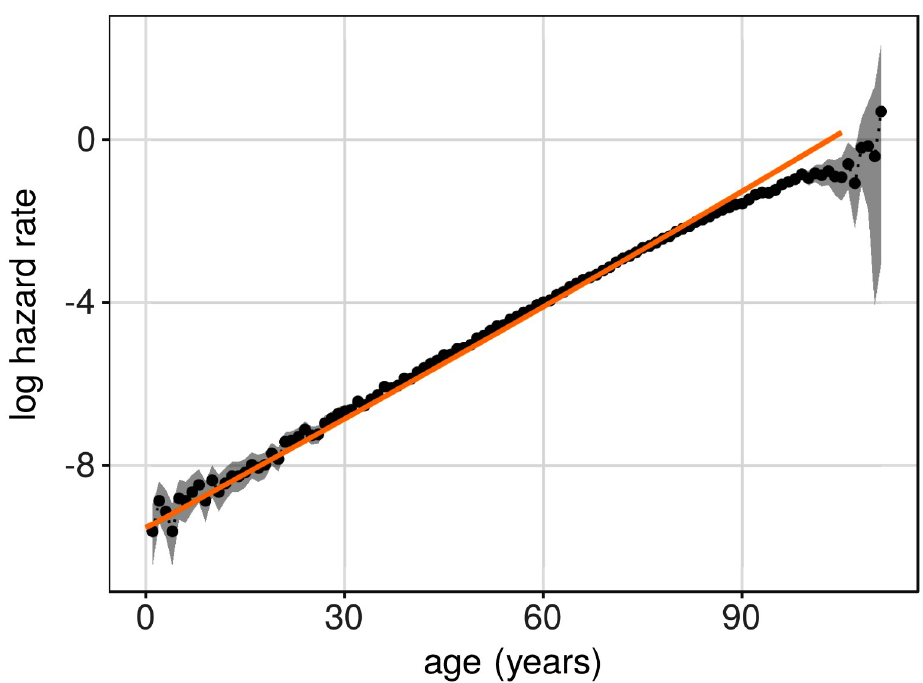
Fig 5. Estimated hazard rates (points) for a model system with heterogeneity in μ 0 . The gray region represents 95% confidence intervals (from a Poisson approximation), and the orange line represents hazard rates for a model system without heterogeneity. Heterogeneity was modeled by sampling values of μ 0 from a normal distribution with mean 550 and variance 4. Other model parameters were: λ = 500, β = 0.485/365, θ = 100. Results are based on 1.2 × 10 5 model